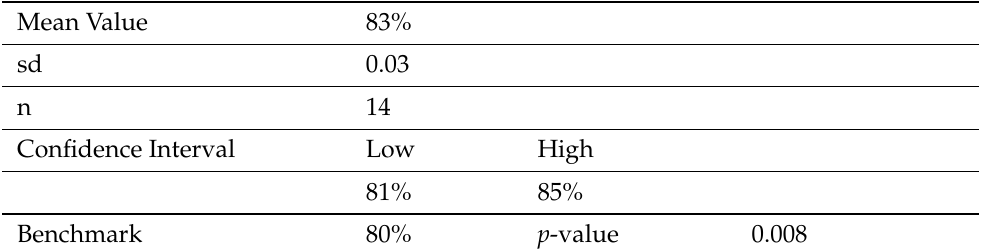
Table 13. Statistics of Per_Utilization for the cobot in HWRCE.